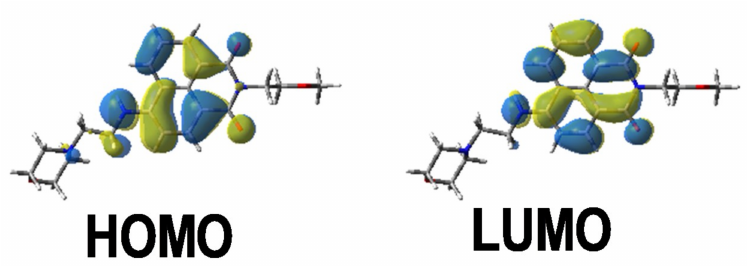
Figure 2. Contour plots of the highest occupied molecular orbital (HOMO) and lowest unoccupied molecular orbital (LUMO) energy levels of Napht-B1 optimized at the B3LYP / 6-31G * level of